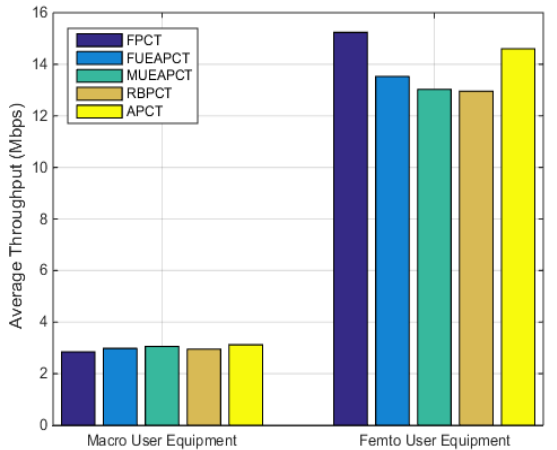
Figure 5. Average throughput under different power control approaches.